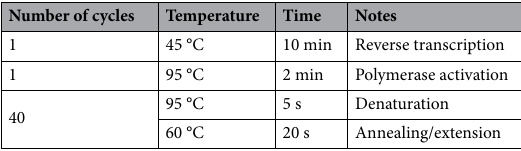
Table 1. qRT-PCR program 2-step cycling.